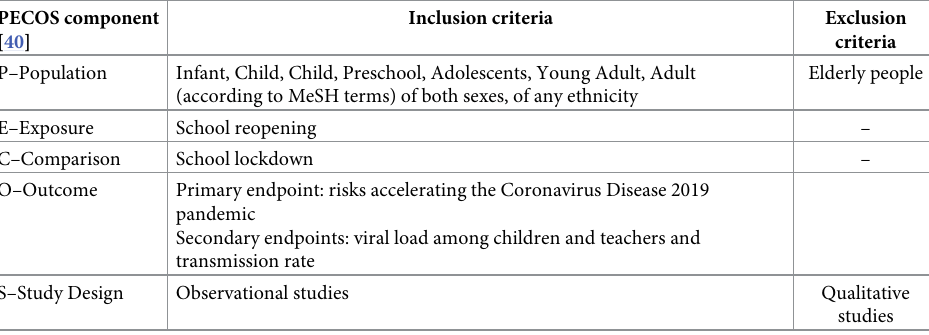
Table 1. PECO acronym for search